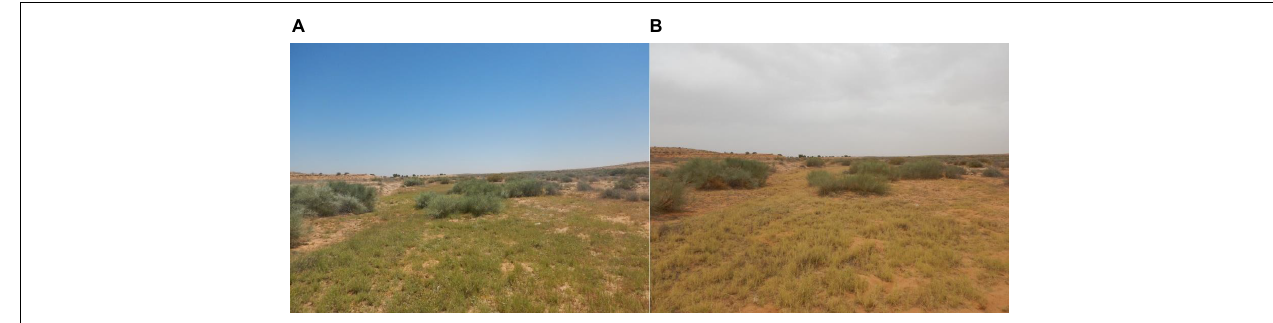
FIGURE 5 | Perennial grass ( Cynodon dactylon ) conditions before (A) and after (B) 1-week intense grazing in Tataouine, Tunisia.